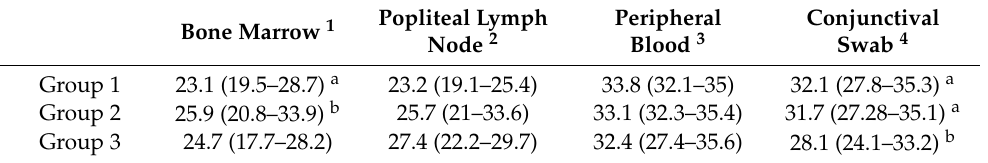
Table 4. Sybr-qPCR results in the different biological samples studied according to clinical signs